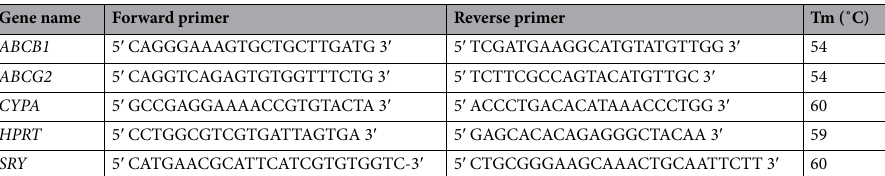
Table 1. Primer sequences used for analysis. Primers were designed using the National Center for Biotechnology Information webpage (www. ncbi. nlm. nih. gov). Primer specificity was confirmed by NCBI Basic Local Alignment Search